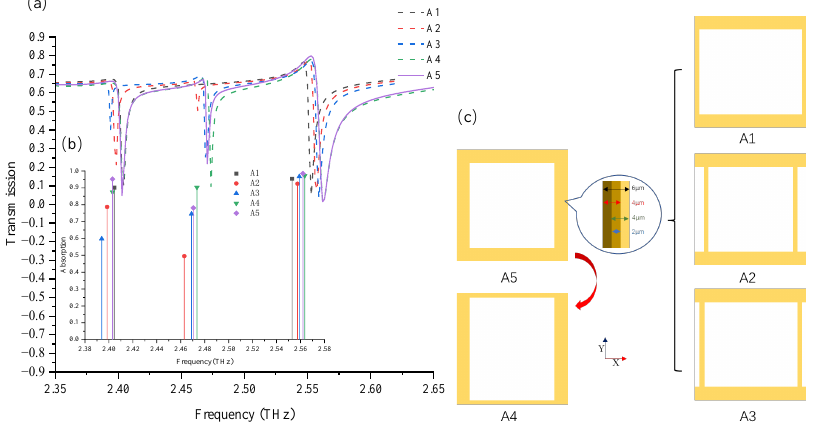
Figure 3. ( a ) Comparison of the simulation transmission spectra of the A1, A2, A3, A4, and A5 structures. ( b ) Comparison of the absolute values of transmission attenuation when the A1, A2, A3, A4, and A5 structures are stimulated in the T1, T2, and T3 modes, respectively. ( c ) Schematics of the A1, A2, A3, A4, and A5 structures transformed in the QR structure. These structures were reduced by 4 µ m in width on the inward side of the Y-axis loop (A1), 2 µ m in width on both sides of the Y-axis loop (A2), 4 µ m in width on the outward side of the Y-axis loop (A3), 4 µ m in width on the inward side of the X-axis loop (A4), and remained unchanged, which was used as a reference (A5). To verify the mimicking ability of the HSO model, we summarized the spectral data based on the QR-DD and HSO models in Figure 5. There are several common features in the resonant responses when comparing the spectral profiles, and the imperceptible numerical difference between them is sufficient to prove the validity and fitness of the HSO